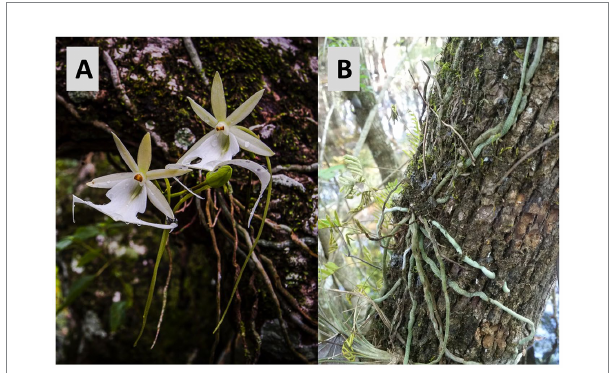
FIGURE 1 (A) Flowers of Dendrophylax lindenii (photo by Larry W. Richardson). (B) Dendrophylax lindenii roots growing on the tree trunk of a phorophyte, Fraxinus caroliniana